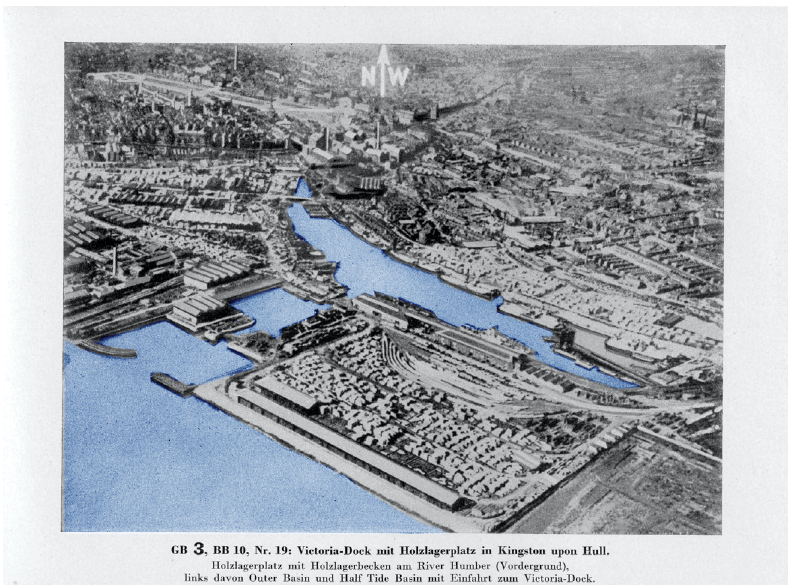
Victoria Dock with timber yard in Kingston upon Hull, England, 1942. Adapted from Oberkommando der Wehrmacht, David Rumsey Map Collection, David Rumsey Map Center, Stanford Libraries.